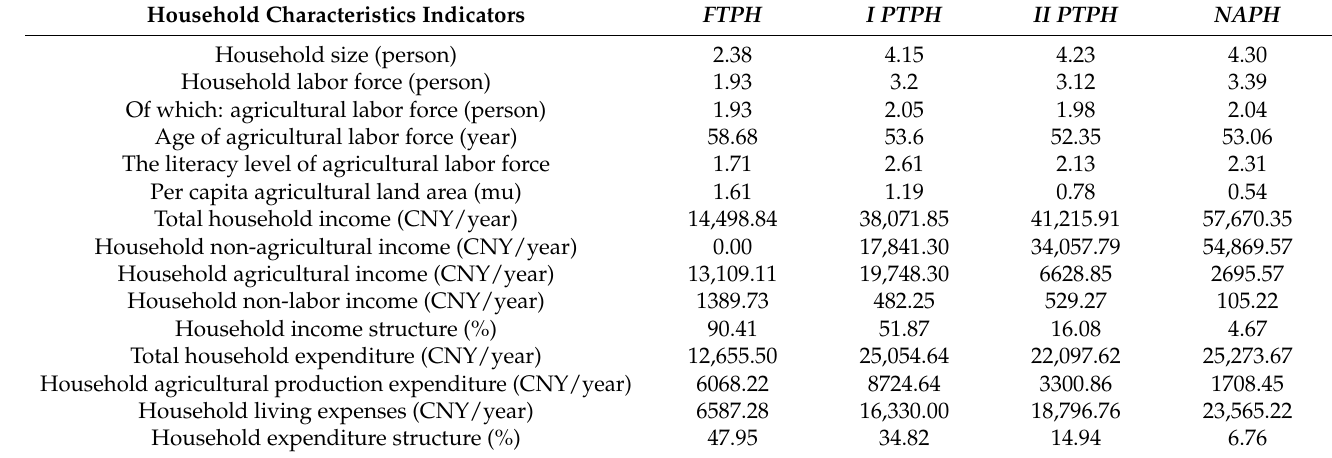
Table 3. Basic household characteristics of different types of peasant